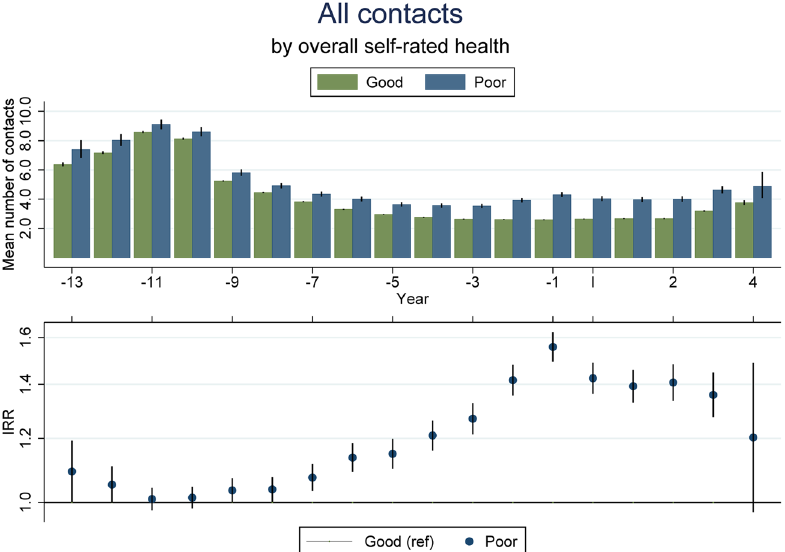
Figure 3. Mean number of yearly GP contacts by years before/since filling out the 11-year questionnaire according to self-rated health (good or bad) in top-panel and adjusted IRR (95%-CI) in bottom panel. IRRs and 95% CIs were estimated using negative binomial regression. Adjusted for sex, age, year, number of siblings, income and parental